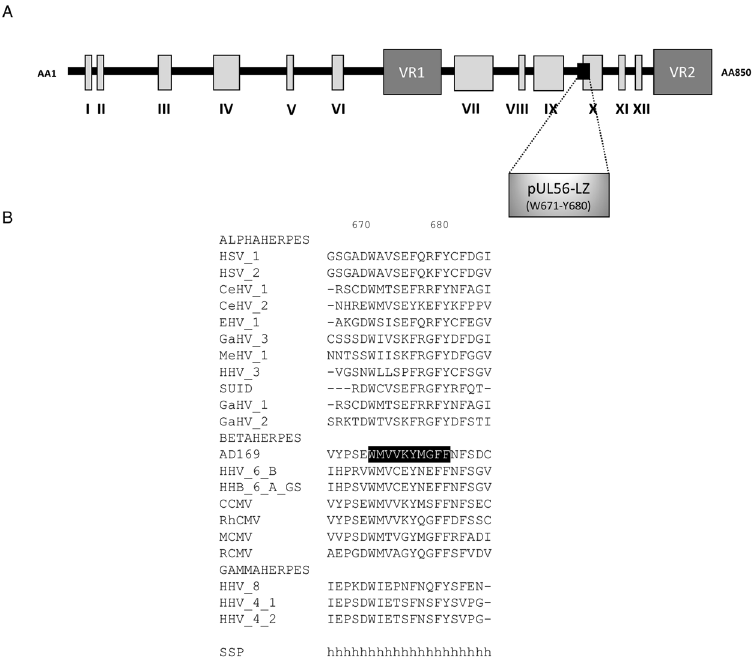
Figure 1. ( A ) Structure of HCMV terminase subunit pUL56 with a putative leucine zipper pattern annotated as pUL56-LZ 22 . ( B ) Sequences alignment of conserved regions from 21 herpesviruses. Sequence numbering is consistent with that of AD169 residues. Key residues are highlighted as white letters on a black background. SSP: Secondary structure prediction of pUL56-LZ (h = α